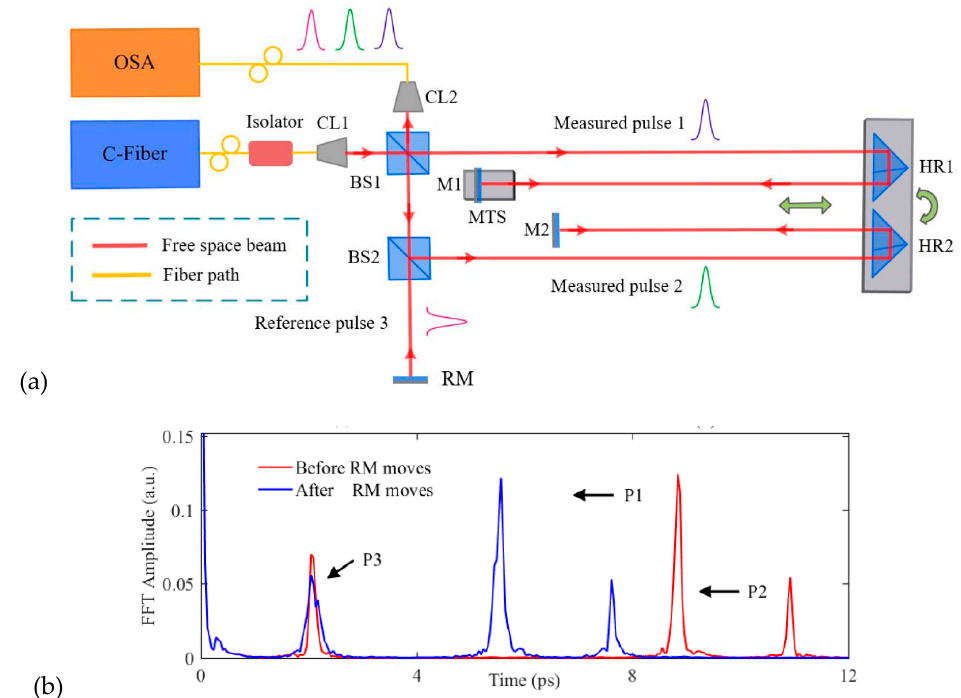
Figure 15. Angle measurement based on the absolute distance measurement by a Michaelson interferometer with a mode-locked femtosecond laser source [62]: ( a ) Optical configuration with two measurement arms; ( b ) Spectrum of the combined beams.